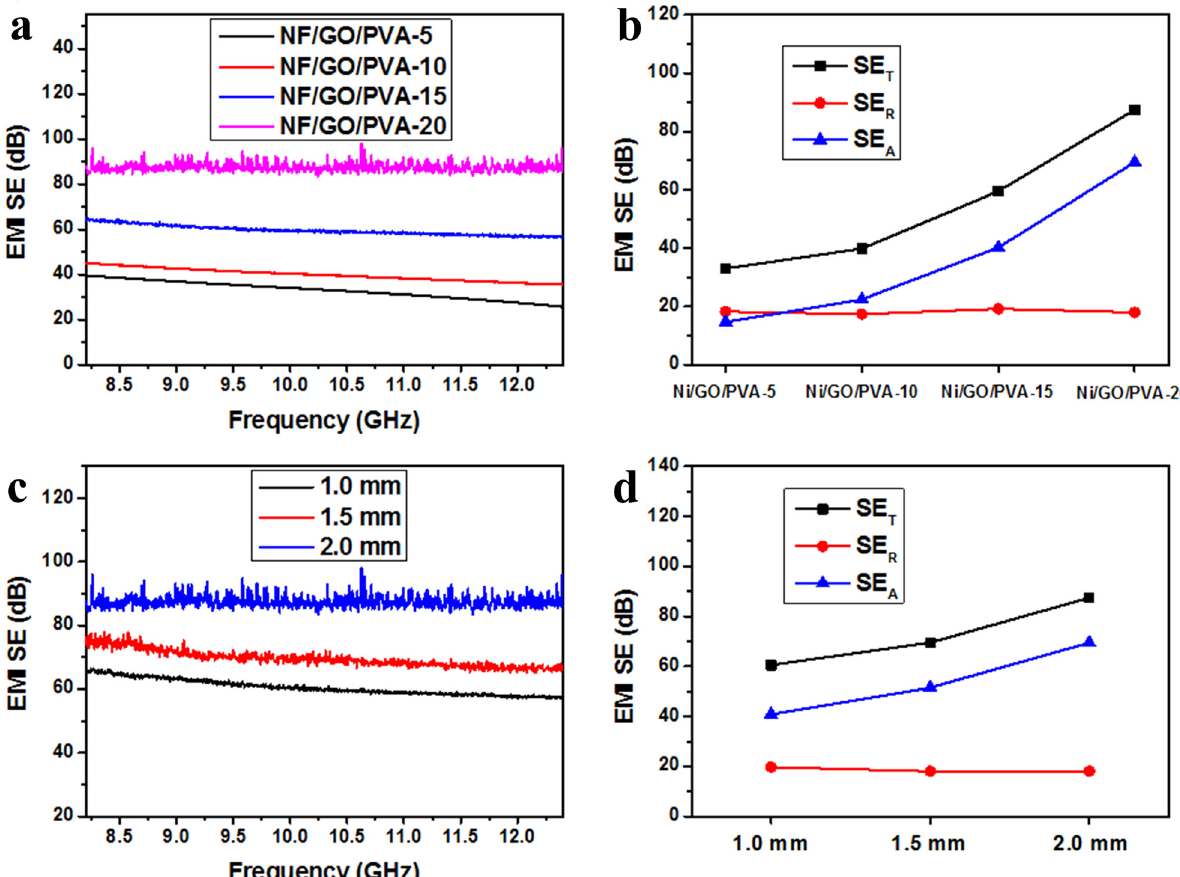
Figure 7: EMI shielding properties of Ni/GO/PVA aerogel: ( a and b ) e ff ect of GO content; ( c and d ) e ff ect of thickness for Ni/GO/PVA - 20